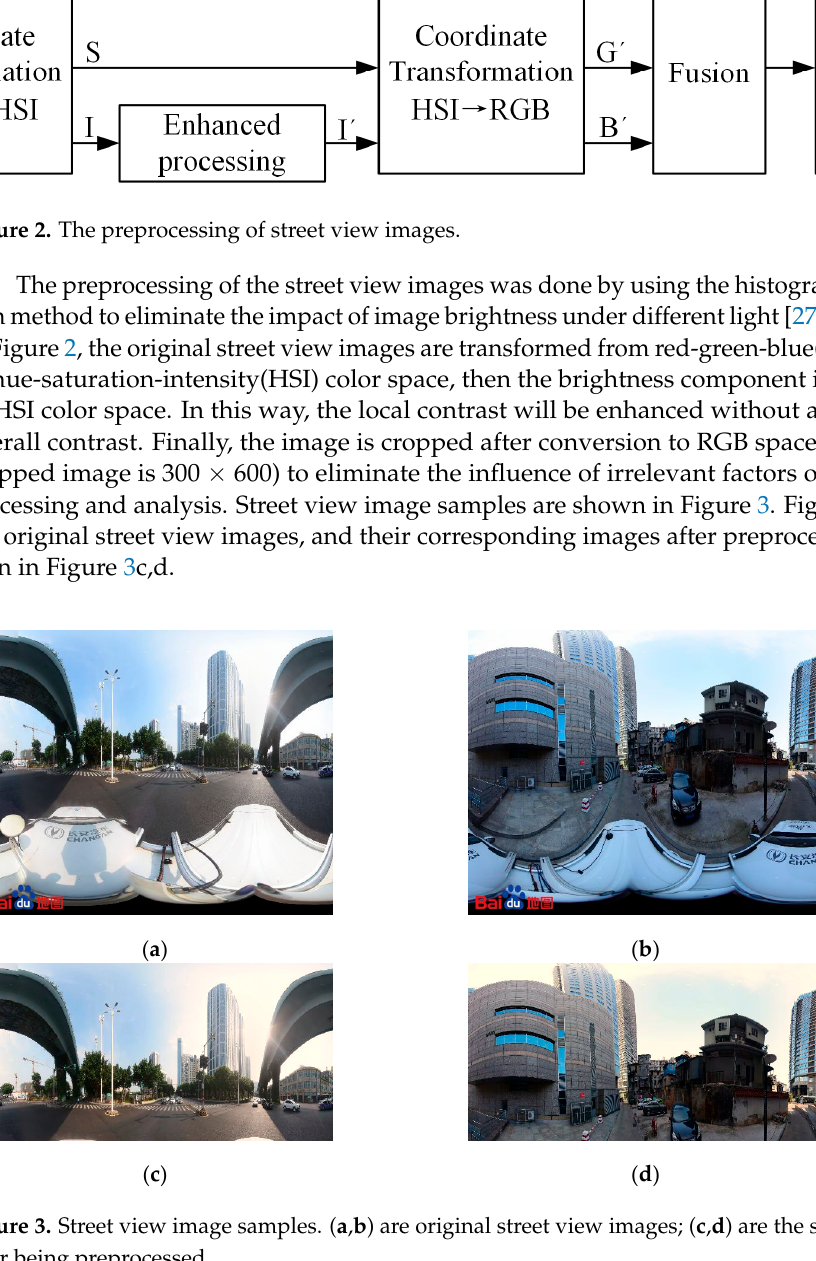
Figure 3. Street view image samples. ( a , b ) are original street view images; ( c , d ) are the same imagery after being preprocessed.